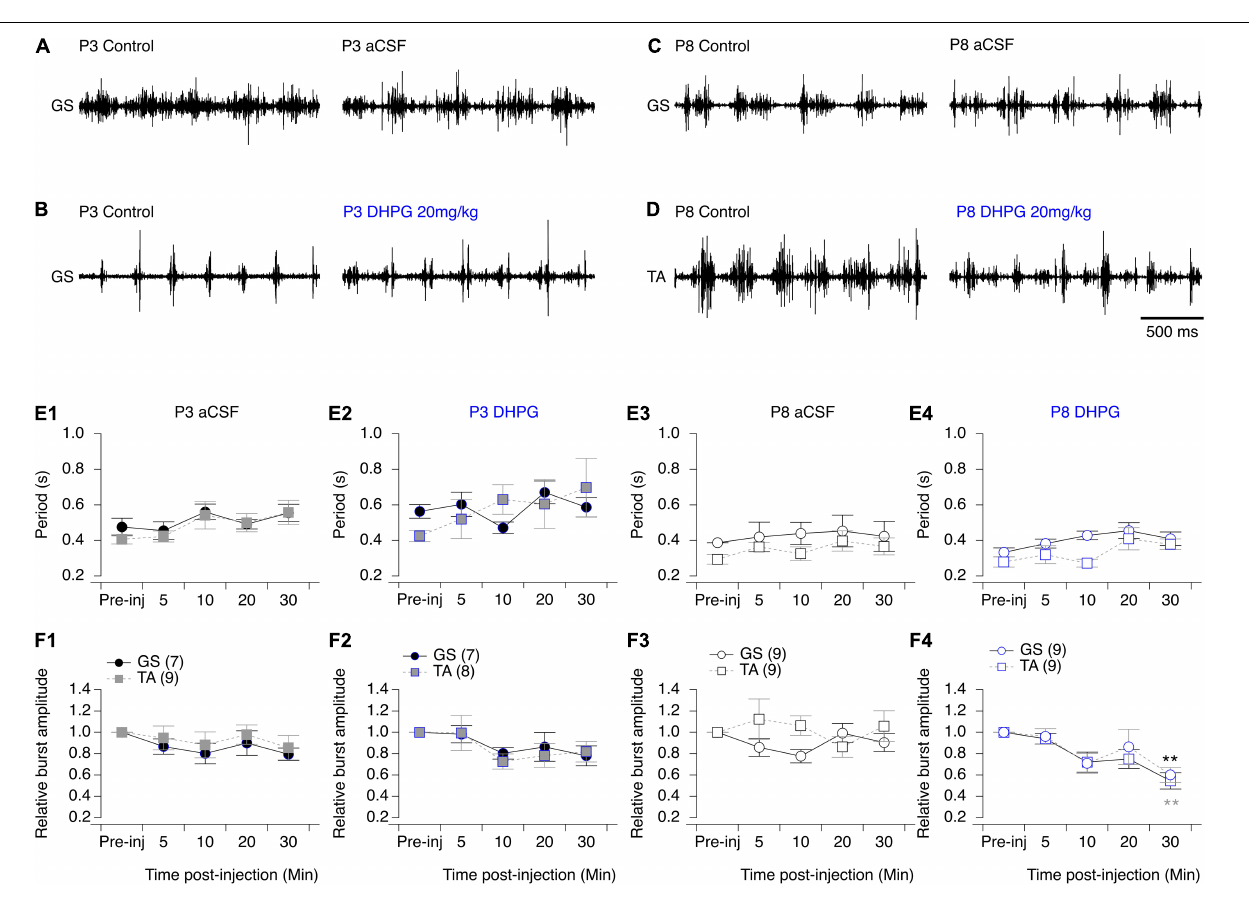
motor bursts recorded from hindlimb muscles ( Figures